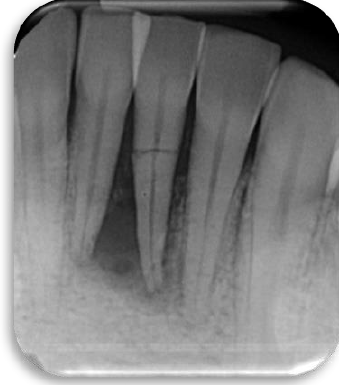
Figure 1. This radiograph shows tooth#24 horizontal fracture and radiolucency in the anterior mandible, as a result of a blow received from the patient playing boxing. mandible, as a result of a blow received from the patient playing